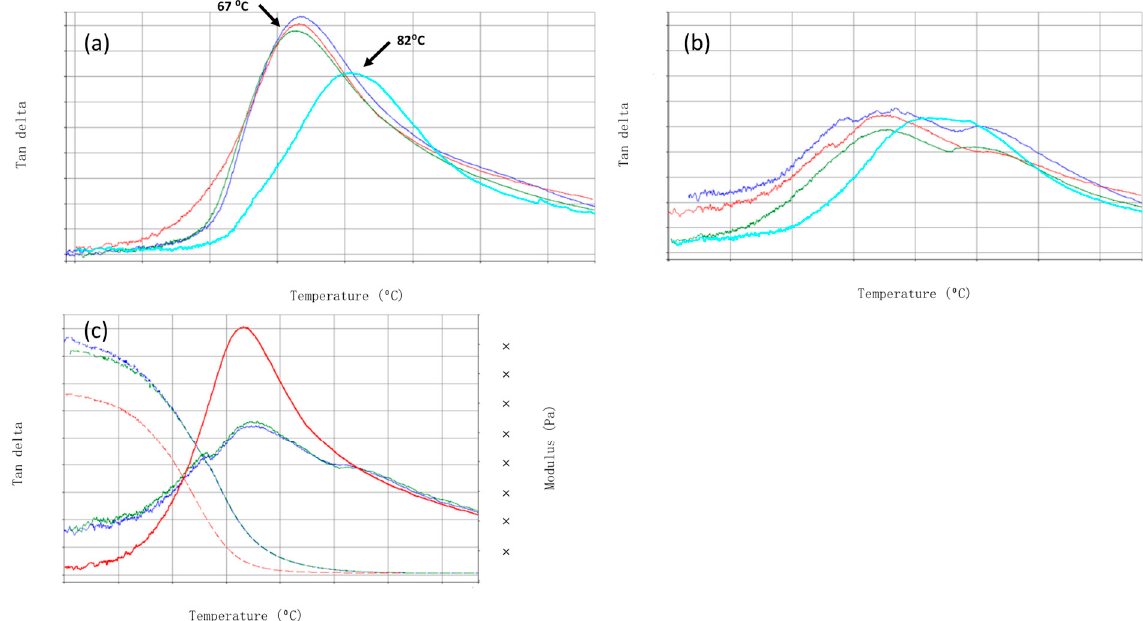
Figure 5. Dynamic mechanical responses (1 Hz in three point bending) of P(tBC6DA). Tan δ vs. temperature of the first scan ( a ) and the second scan ( b ). Arrows point to potential low and high temperature T g s. Samples polymerized at different temperatures are labeled with colors of RT (red), 40 °C (dark blue), 50 °C (green), 60 °C (light blue), ( c ) Tan δ and modulus vs. temperature for P(tBC6DA-RT), first scan (red), second scan (blue), third scan (green).